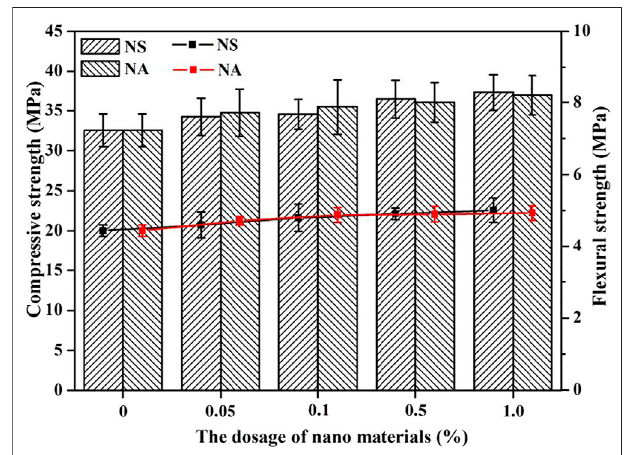
FIGURE 1 | Slum of concrete as a function of the dosage of nanoparticles.